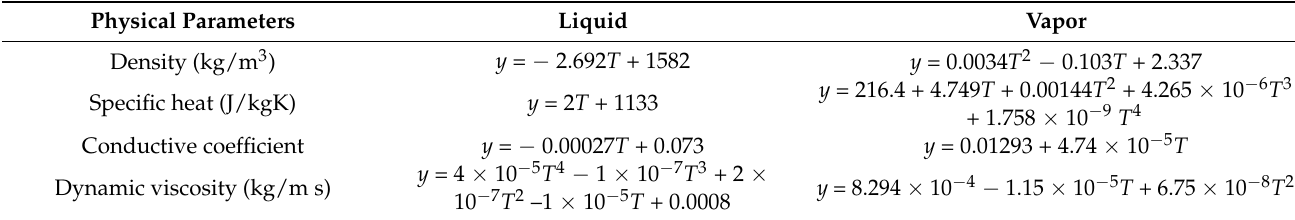
Table A2. Thermodynamic properties of the Novec 7100 (vapor and